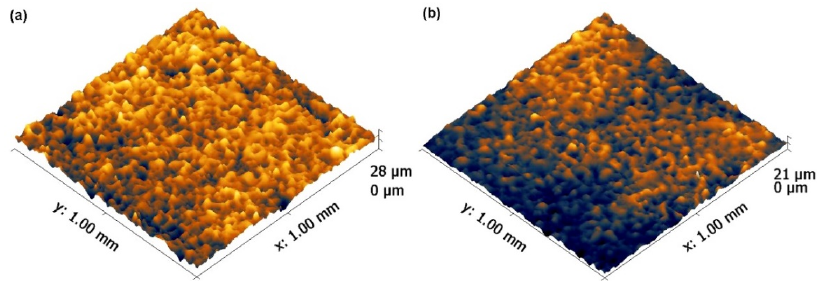
Figure 3. Color filtered relief of the sample surface machined by a 100 mm × 100 mm electrode. ( a ) Sample 64 (electrode material: copper), ( b ) Sample 65 (electrode material: graphite).